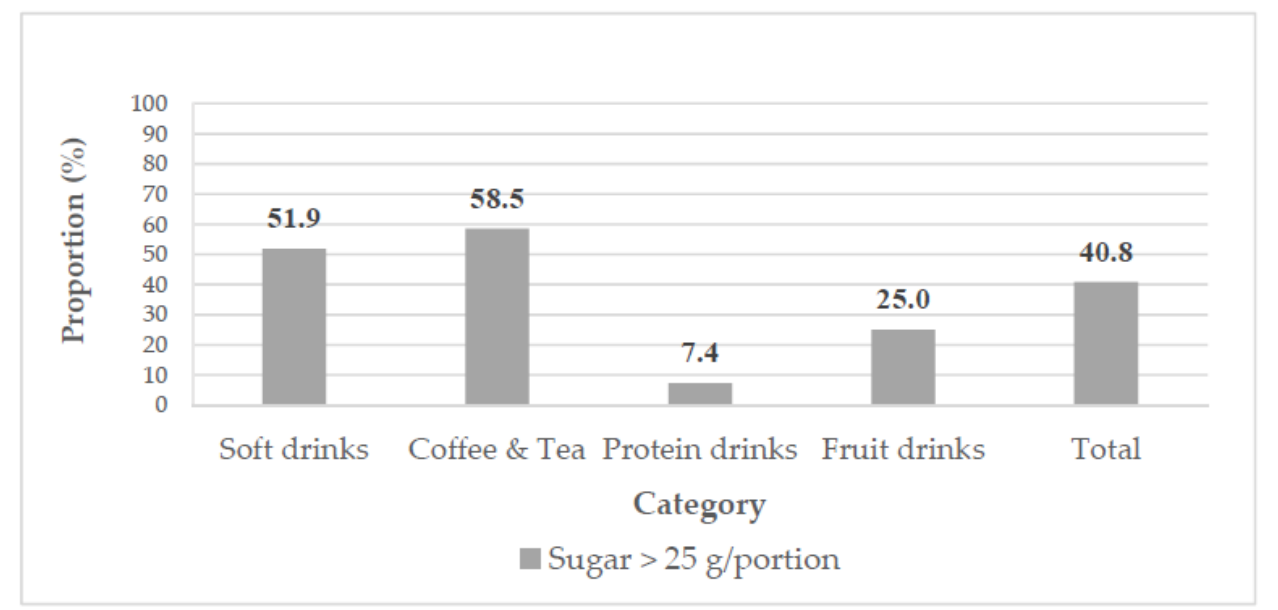
Figure 4. Distributions of >25 g sugar per portion in SSBs that were “not” classified as high sugar according to the Chilean criteria ( n =